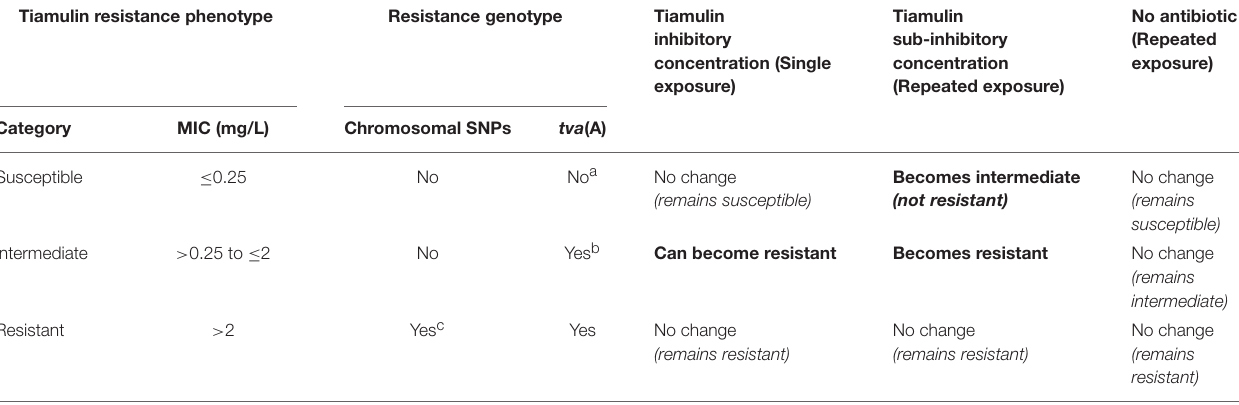
TABLE 3 | Hypothesis for pleuromutilin resistance development in B. hyodysenteriae